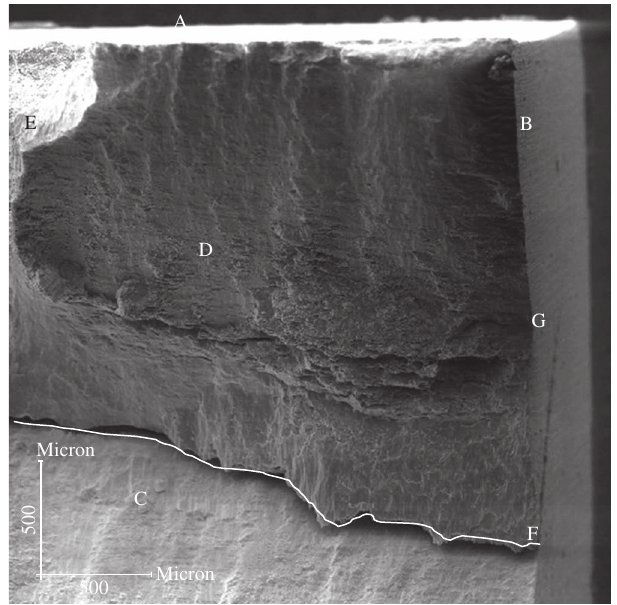
Figure 9. Fractured surface of a specimen tested at 274 MPa. Original mag- nification: 31X.